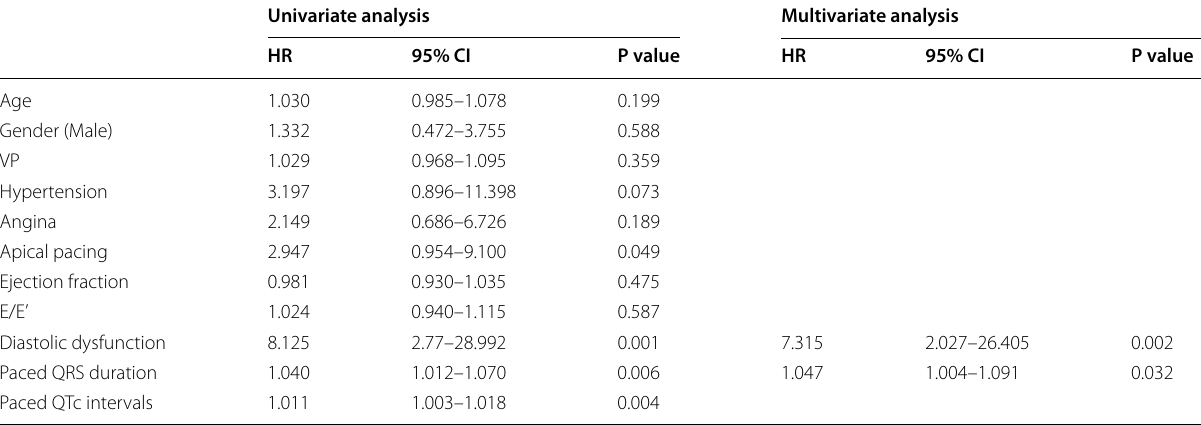
VP Ventricular pacing percentage, QTc Corrected